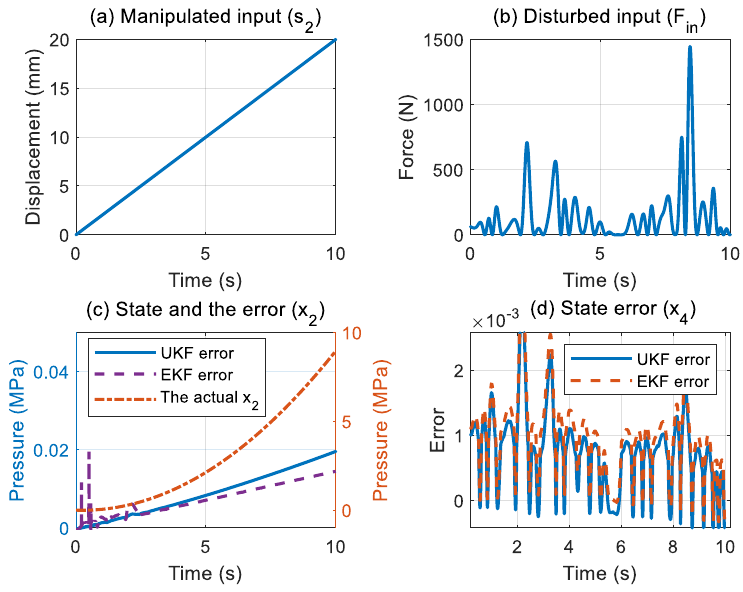
Figure 11. The input and states in the open-loop test. ( a ) manipulated input ( s 2 ); ( b ) disturbed input ( F in ); ( c ) state and the error ( x 2 ); ( d ) state error ( x 4 ).